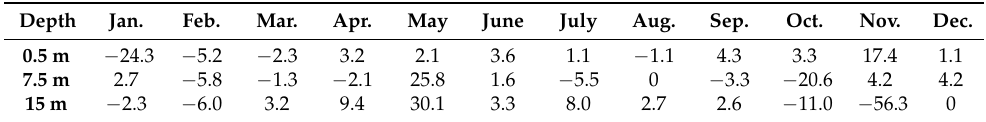
Figure 7. Nitrate nitrogen in the overlying water of in situ experimental reactor over time. ( A ) Before stratification. ( B ) After stratification. Table 2. Variation of concentration of ammonia in every month. Depth Jan.